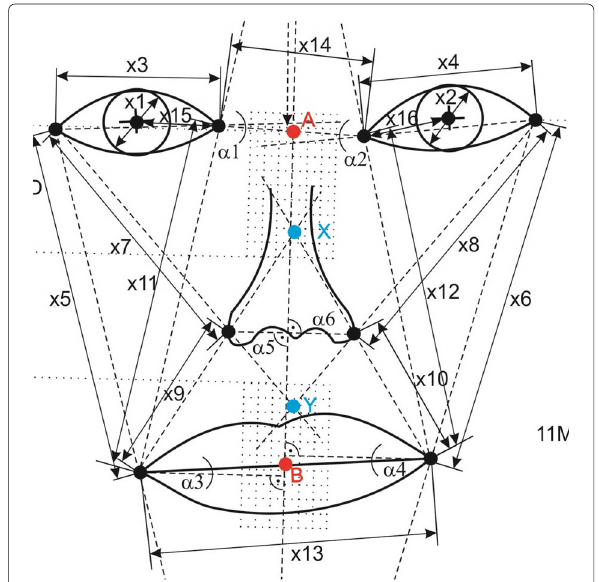
Fig. 10 Fragment of template of facial asymmetry with the designated distance